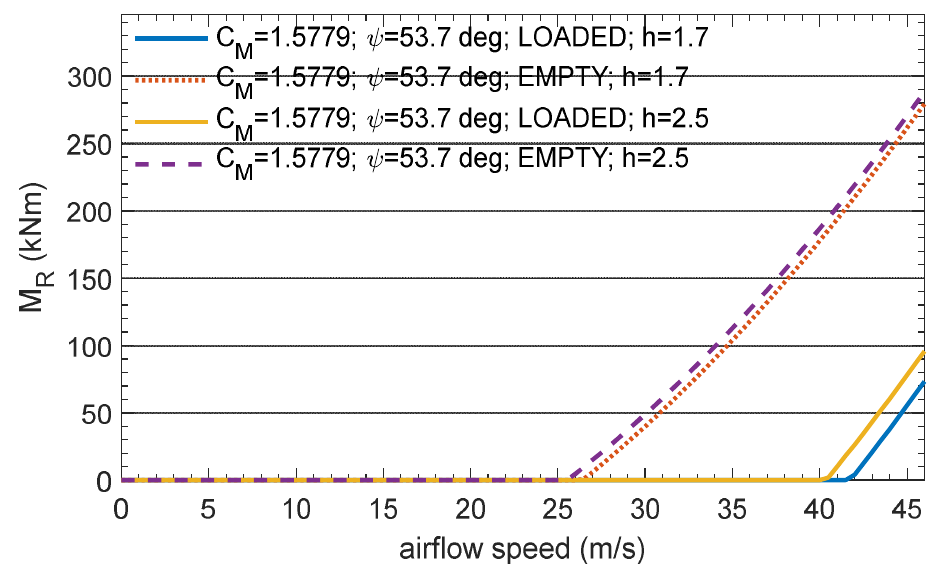
Figure 11. Reaction moment of the cargo-platform locking device in reference to the longitudinal vehicle axis assuming constant b = 1 m, b/h = 0.59 for h = 1.7 m, and b/h = 0.4 for h = 2.5 m, C M — aerodynamic coefficient, ψ —yaw angle of the relative airflow velocity.